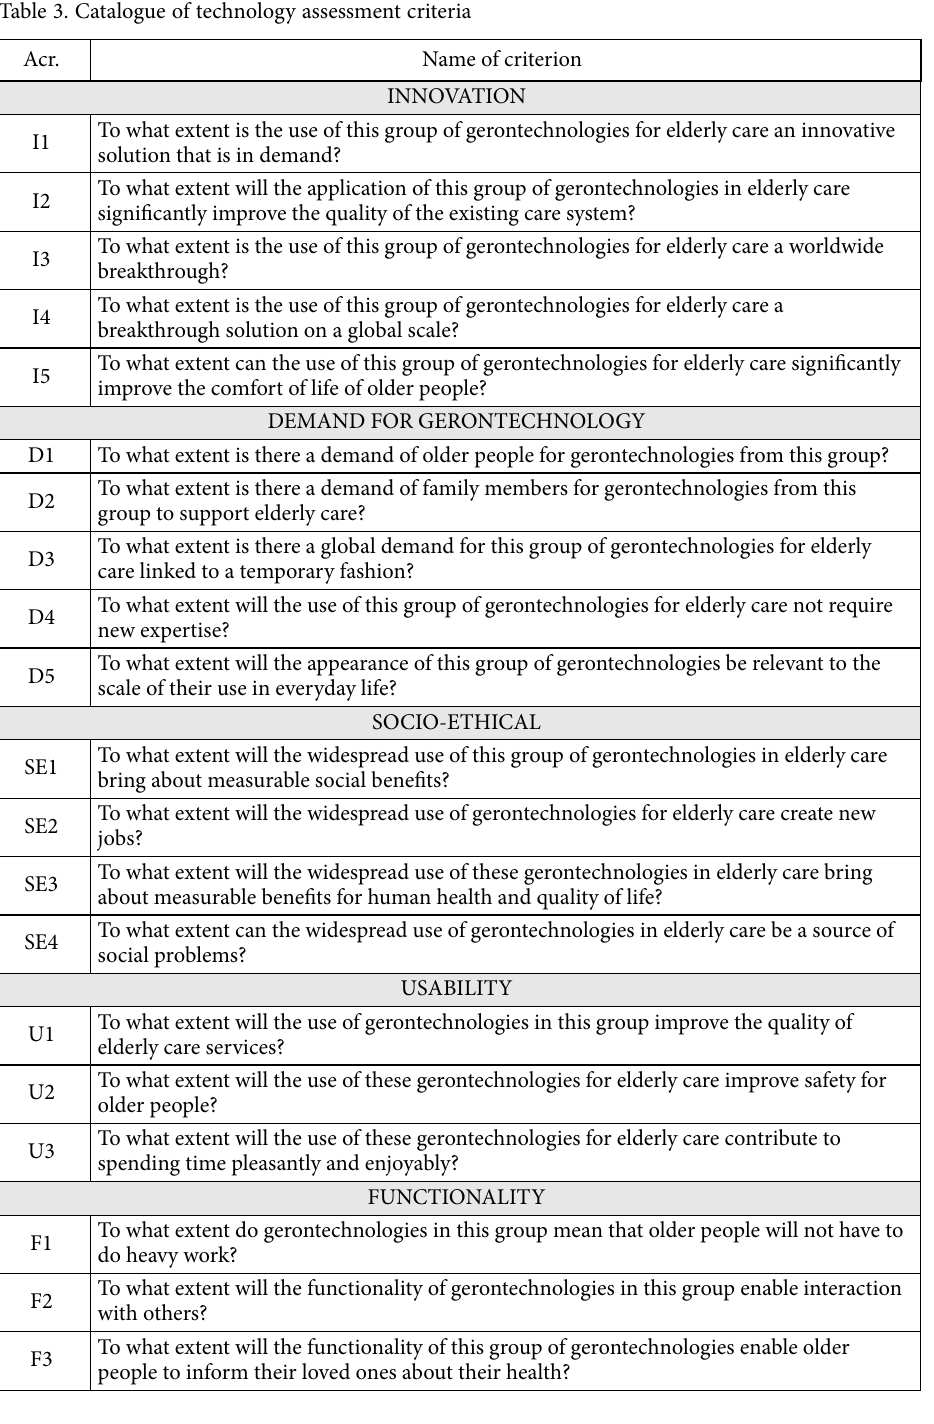
Table 3. Catalogue of technology assessment criteria